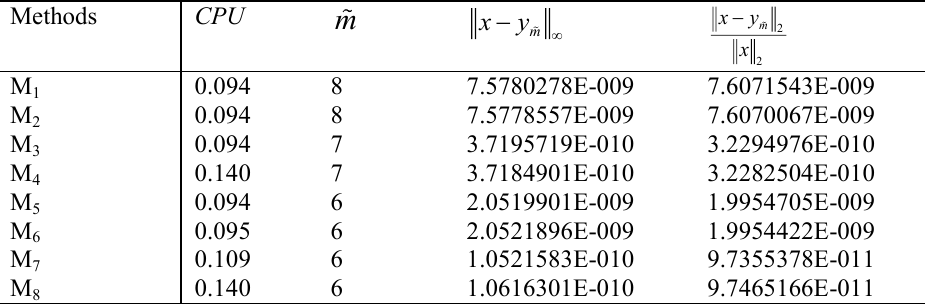
Table.2. CPU times in seconds, iteration numbers m and relative norms of the errors obtained by Algorithm 1 using the methods